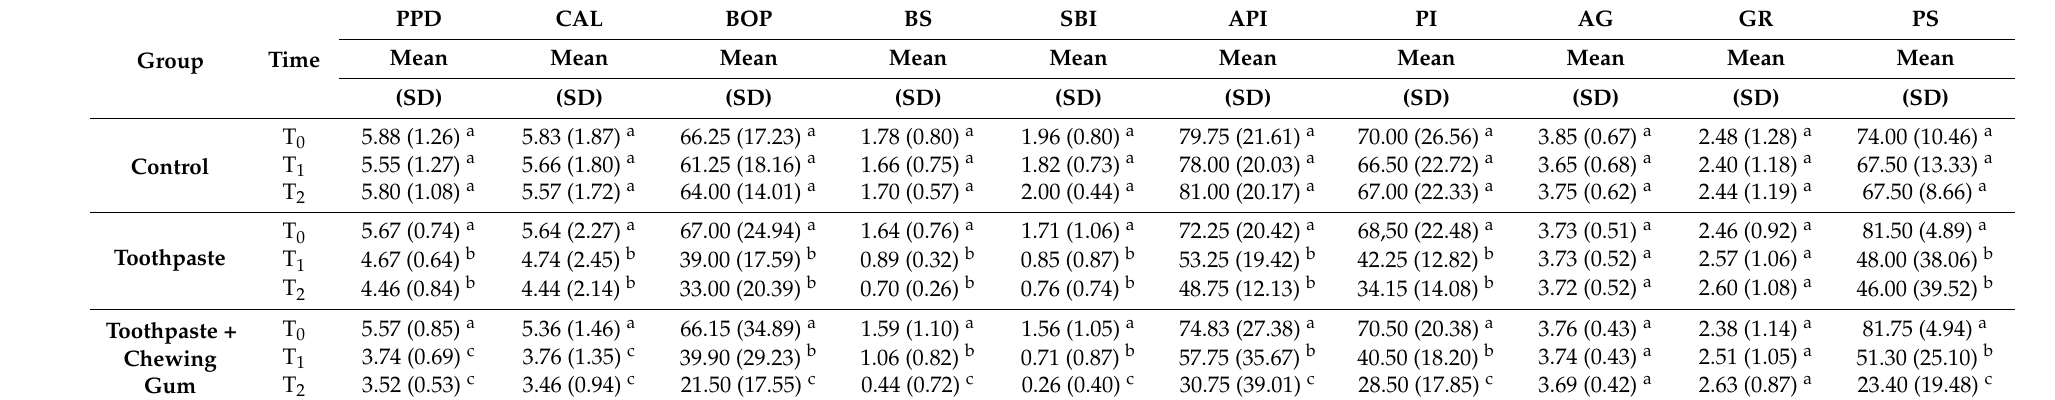
Table 3. Descriptive statistics of periodontal clinical